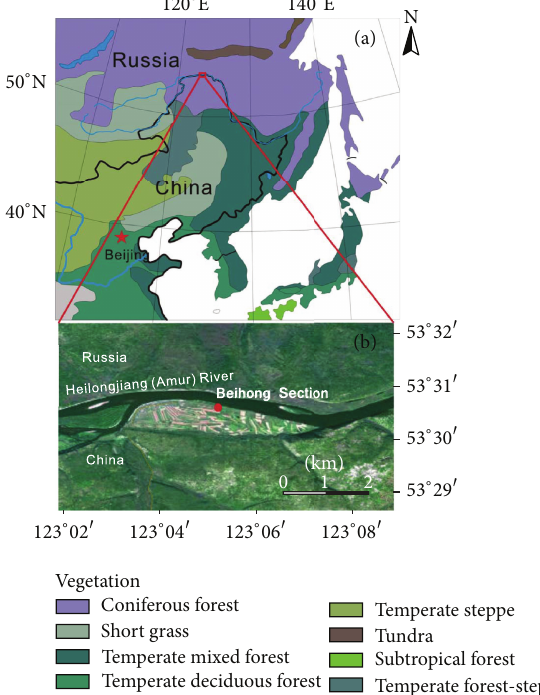
Figure1:Mapofthestudyarea.(a)Redrectangleindicatesthestudy area. (b) Red dot shows the Beihong